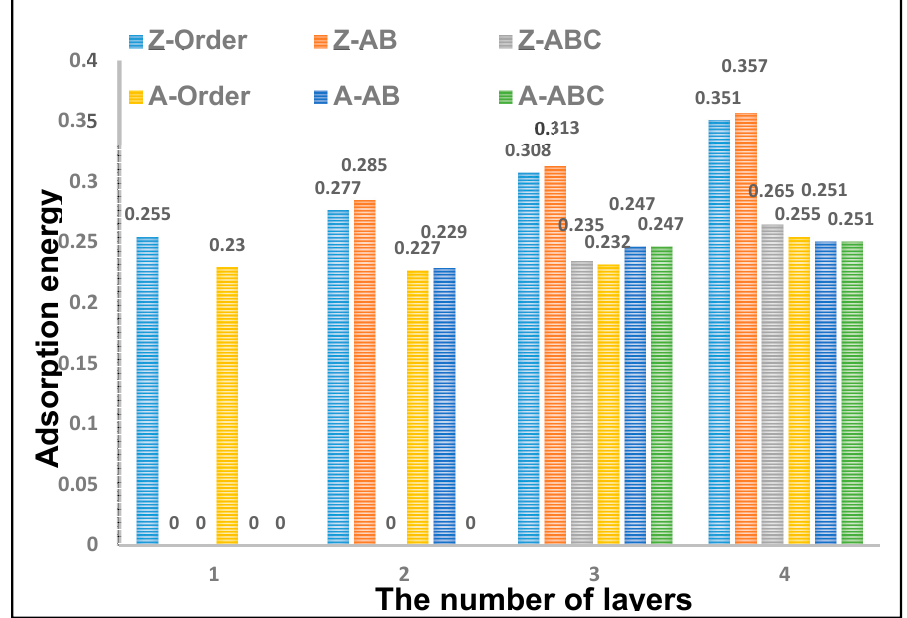
Figure 3. The comparison of adsorption energy between six types of the stacked graphenes with one to four layers; the Order, AB, and ABC stackings of zigzag- and armchair-graphenes are represented by Z-Order, Z-AB, Z-ABC, A-Order, A-AB, and A-ABC, respectively.